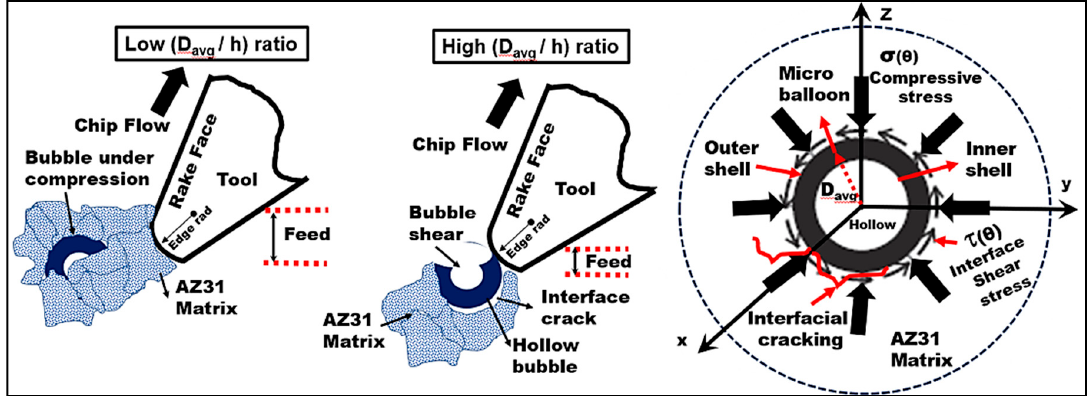
Figure 4. Effect of (Davg/h) ratio on hollow microballoon stress state during cutting. Figure 4. E ff ect of (Davg / h) ratio on hollow microballoon stress state during